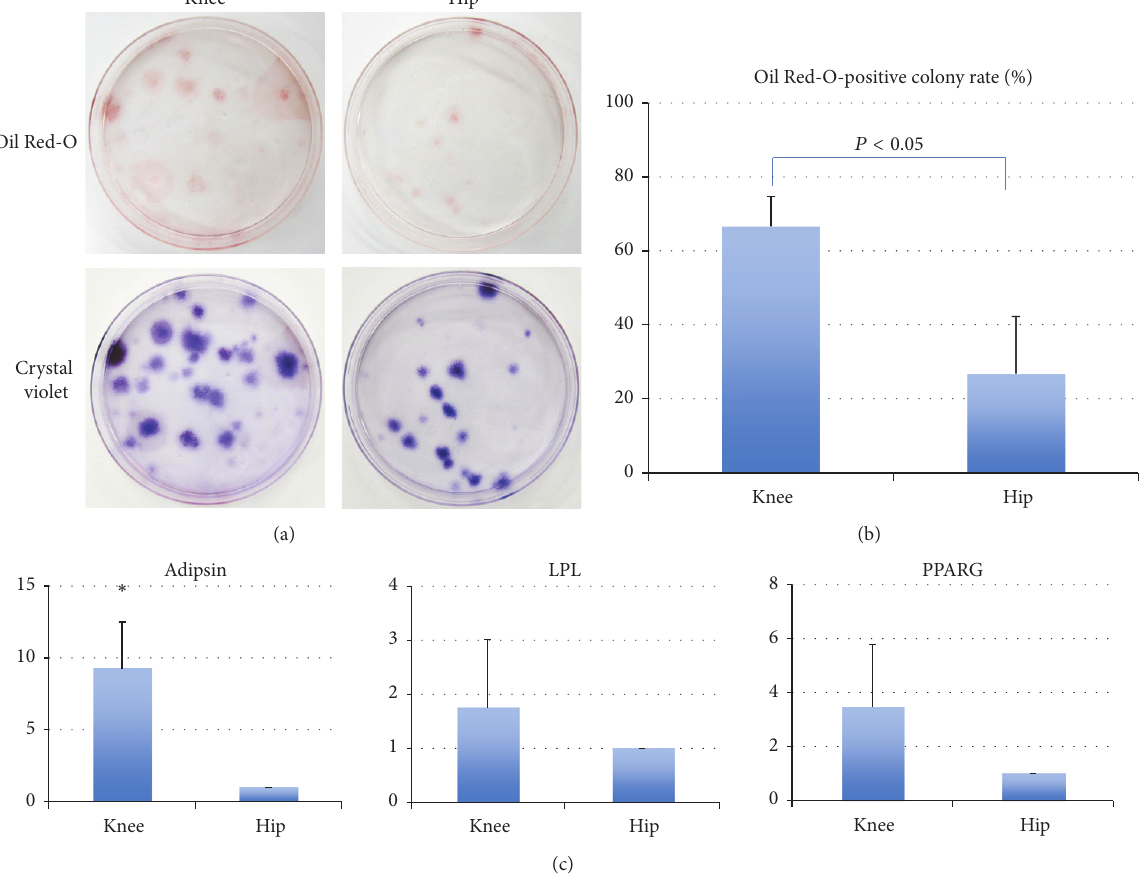
Figure 5: Adipogenic potential about each synovial cell. (a) Colonies staining positively with Oil Red-O and crystal violet in each cell. (b) Proportion of Oil Red-O-positive colonies in relation to the total number of colonies in each MSC. Values are shown as the mean and standard deviation of 6 donors. ∗ The rate of Oil Red-O-positive colonies from the knee was significantly higher than that from hip (Mann–Whitney U test, 𝑃 < 0.0001 ). (c) Quantitative real-time PCR data from 3 representative donors are shown. The bar means standard